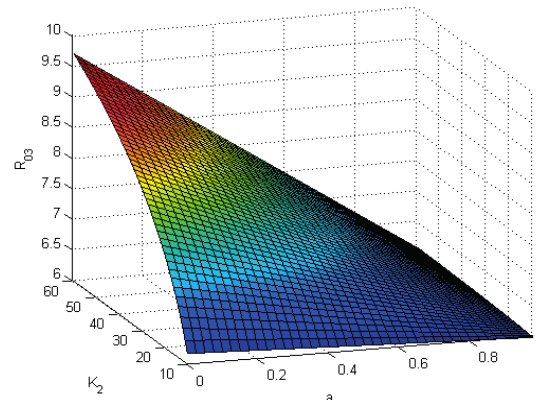
R is a function of a and 03